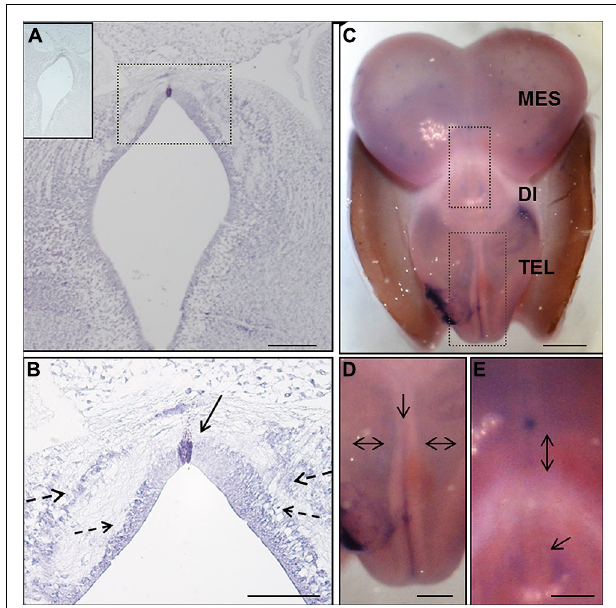
FIGURE 2 | In situ hybridization of EphA7 during chick brain development. (A,B) Frontal section of prosomere 1 of the HH25 chick embryo, showing the expression of this transcript in the midline cells of the diencephalic roof plate (continuous arrow in B ), and in the alar and lateral plates forming two columns parallel to the ventricular wall (discontinuous arrow in B ). Upper left in (A) Sense riboprobe control. (C–E) Whole mount in situ hybridization of the HH30 embryo brain. (C) Expression of the transcript along the encephalon, including the telencephalic midline (arrow in D ) and alar plate (double arrows in D ), as well as around the pineal gland (arrow in E ) and in the diencephalic–mesencephalic boundary (double arrow in E ).Tel:Telencephalon; Di: Diencephalon; and Mes: Mesencephalon. Bars in (A) = 200 μ m; (B) = 100 μ m; (C) = 1 mm; and in (D,E) = 0.5 mm.